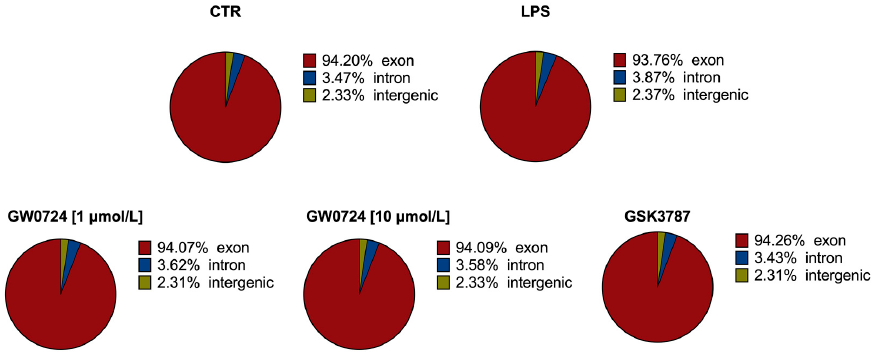
Figure 1. Distribution of mapped reads to genes structures.